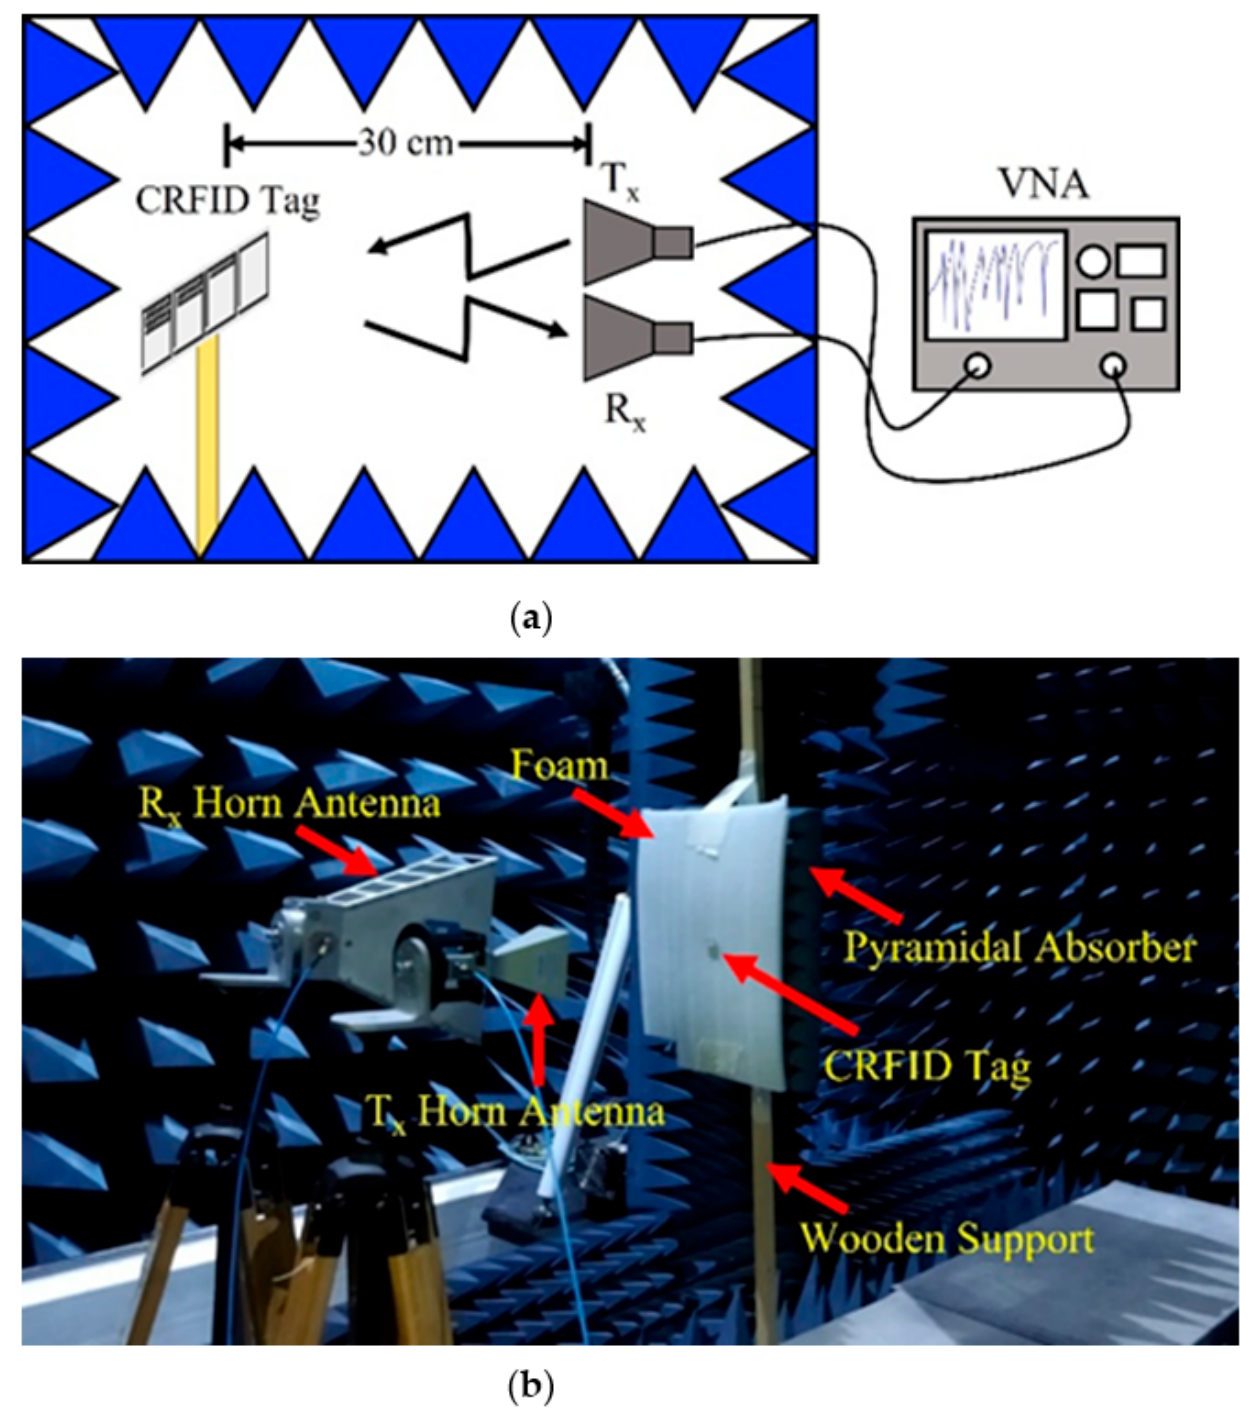
Figure 17. Measurement setup: ( a ) schematic of the bi-static configuration; ( b ) photograph of the RCS measurement setup inside anechoic chamber.